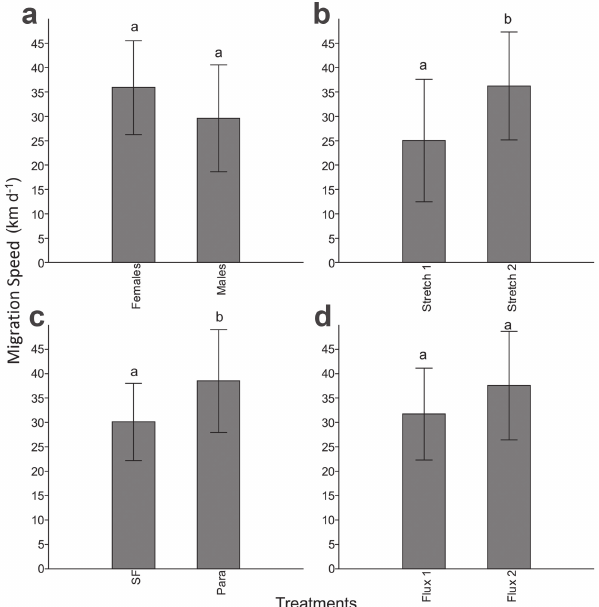
Fig. 3. Comparison of average up-river migration speed of Prochilodus costatus in a. males and females, b. river stretches for fish captured in the Pará River, c. fish captured in the Pará River and São Francisco River in S2, and d. migration intervals in S2. Bars represent the standard deviation. Different letters denote statistically significant differences in migration speed. S1 and S2: river stretches.